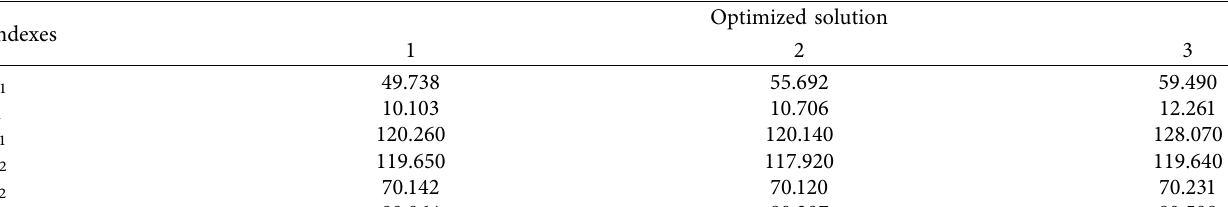
Figure 8: Pareto optimal solution. Table 4: The optimized indices (unit: mm).